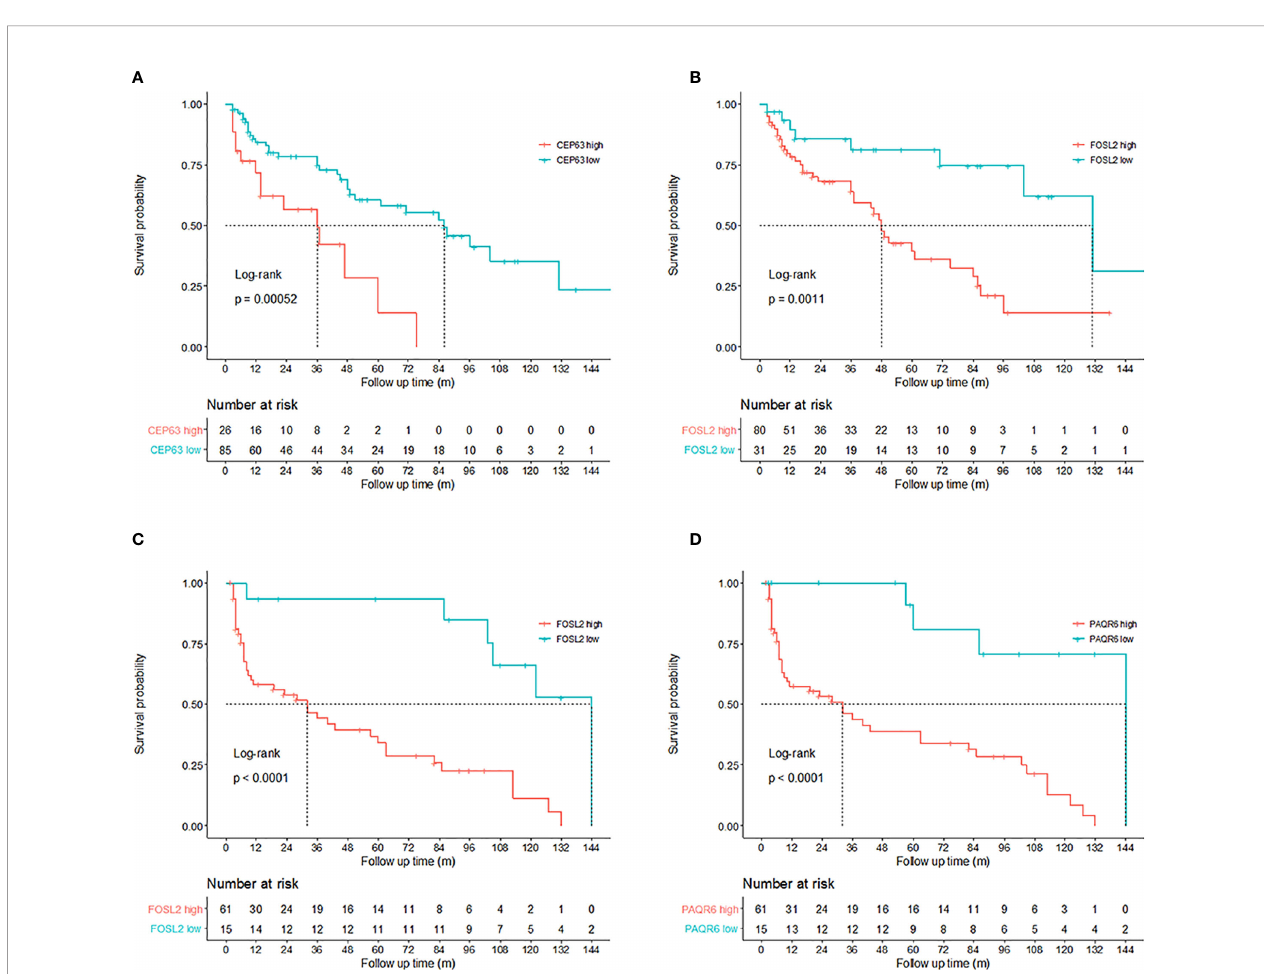
FIGURE 3 | Prognosis prediction by 3 identi fi ed genes. Kaplan – Meier curves revealed that copy number gains of (A) CEP63 and (B) FOSL2 were related to poor disease-free survival (DFS) in non-muscle-invasive bladder cancer (NMIBC) patients (log-rank test, p<0.01). Cutoff points of copy number ratios relative to TATA-box binding protein (TBP) gene were 2.82 and 0.95 for CEP63 and FOSL2, respectively. Copy number gains of (C) FOSL2 and (D) PAQR6 were related to poor DFS in muscle-invasive bladder cancer (MIBC) patients (log-rank test, p<0.01). Cutoff points of copy number ratios of FOSL2 and PAQR6 were 0.99 and 0.78,